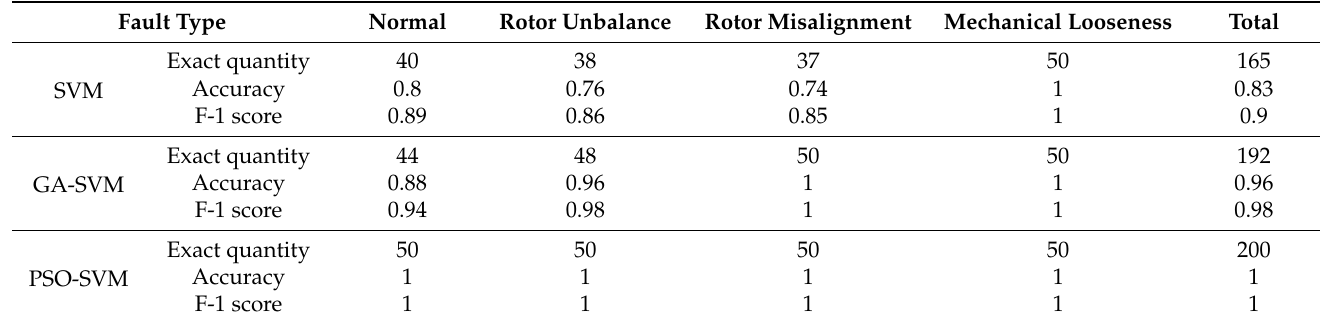
Figure 11. The test results based on GA-SVM model. ( a ) The classification results ( b ) The fitness change curve. Table 6. Comparison of classification performance of three fault pattern recognition